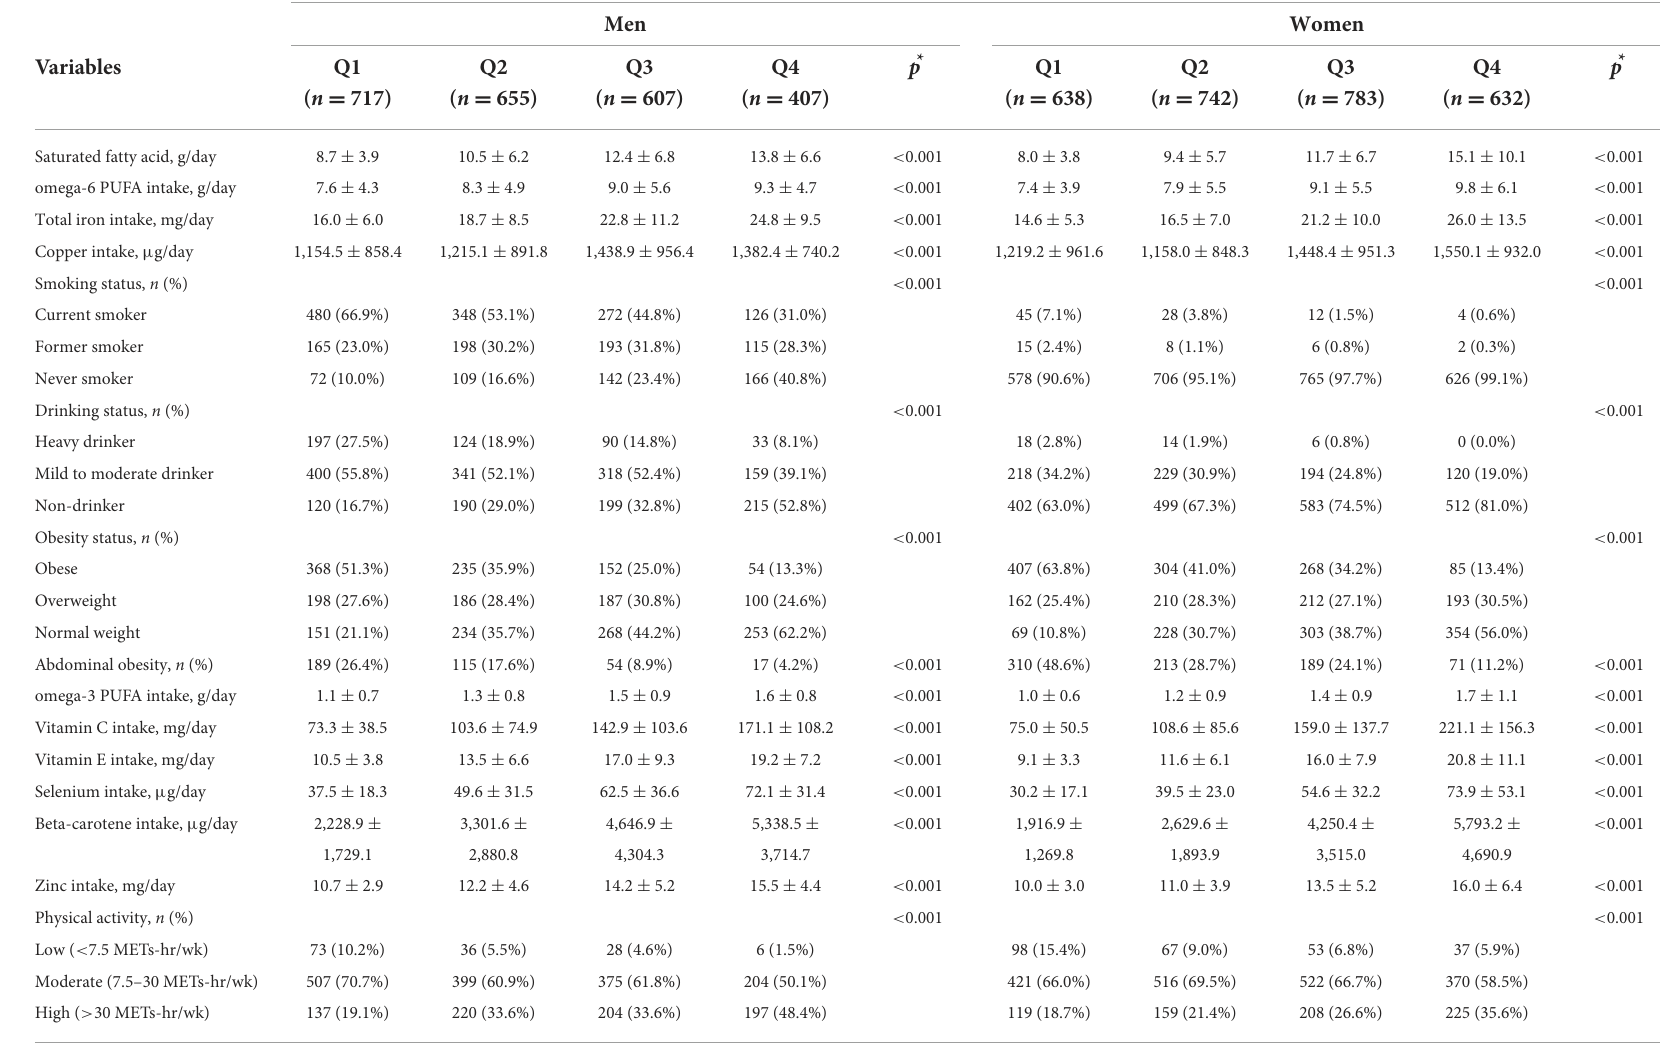
TABLE 3 Individual components of the score by oxidative balance scores